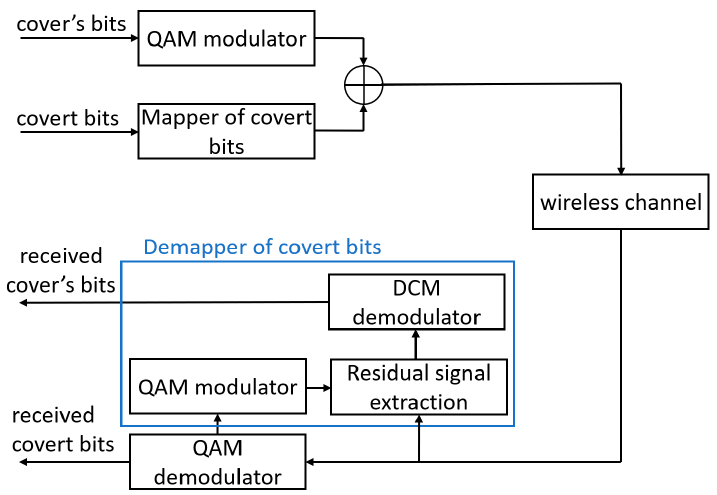
Figure 5. Receiver and transmitter (framework) of phase drift-based covert